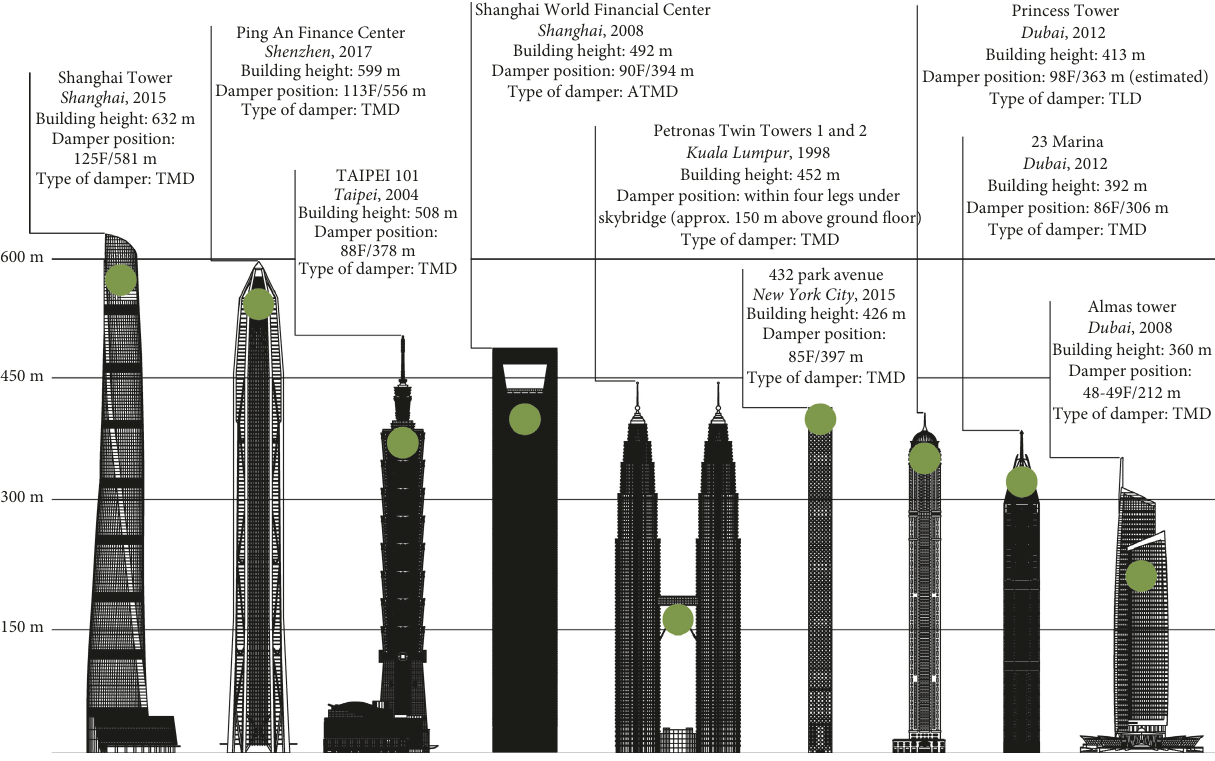
Figure 1: Tallest completed buildings with dampers